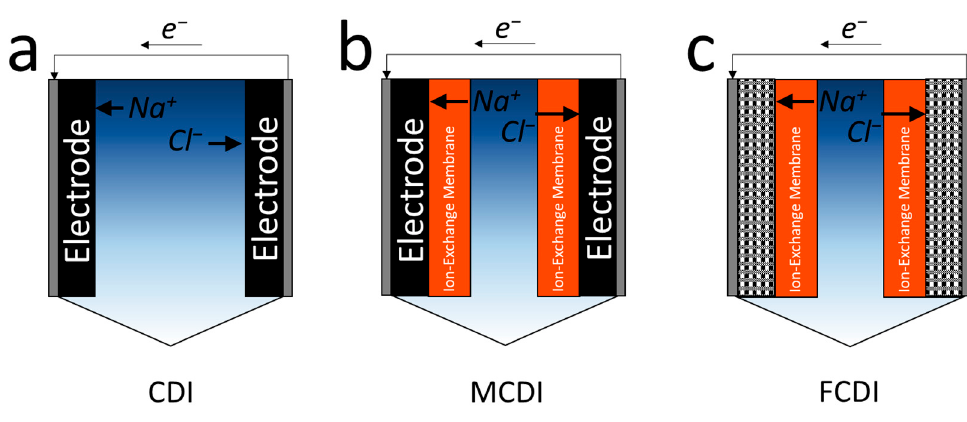
Figure 2. Schematic and working principle of ( a ) capacitive deionization (CDI), ( b ) membrane deionization (MCDI), and ( c ) flow-electrode capacitive deionization (FCDI) capacitive deionization (MCDI), and ( c ) flow-electrode capacitive deionization (FCDI) systems.